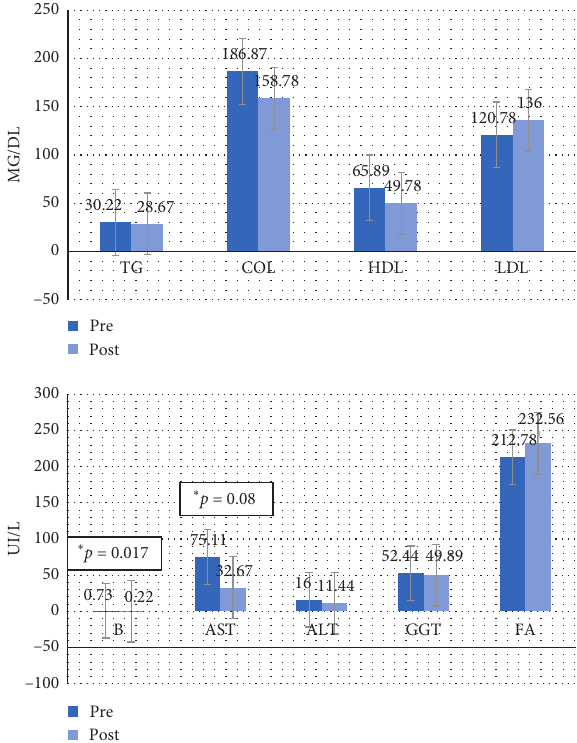
Figure 5: Average values of the pre-post parameters for group 2. TG � triglycerides, COL � total cholesterol, HDL � HDL choles- terol, LDL � LDL cholesterol, B � bilirubin, AST � aspartate ami- notransferase, ALT � alanine aminotransferase, GGT � gamma- glutamyl transferase, FA � alkaline